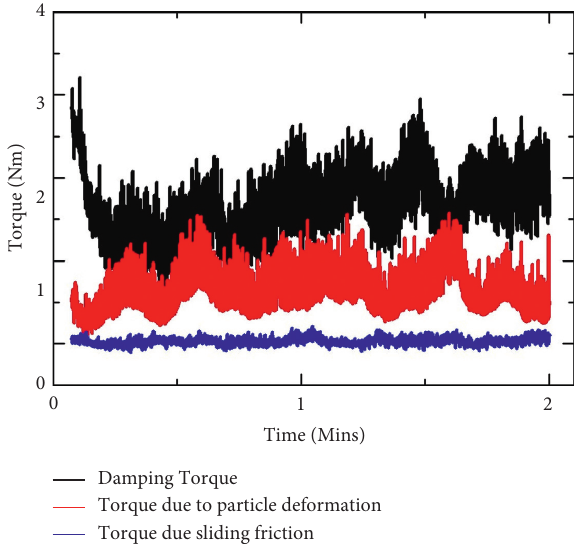
Figure 6: Time history of the rotary damper with a no-gap model using 3mm diameter particles, decomposition of torque due to particle deformation, and torque due to sliding friction.